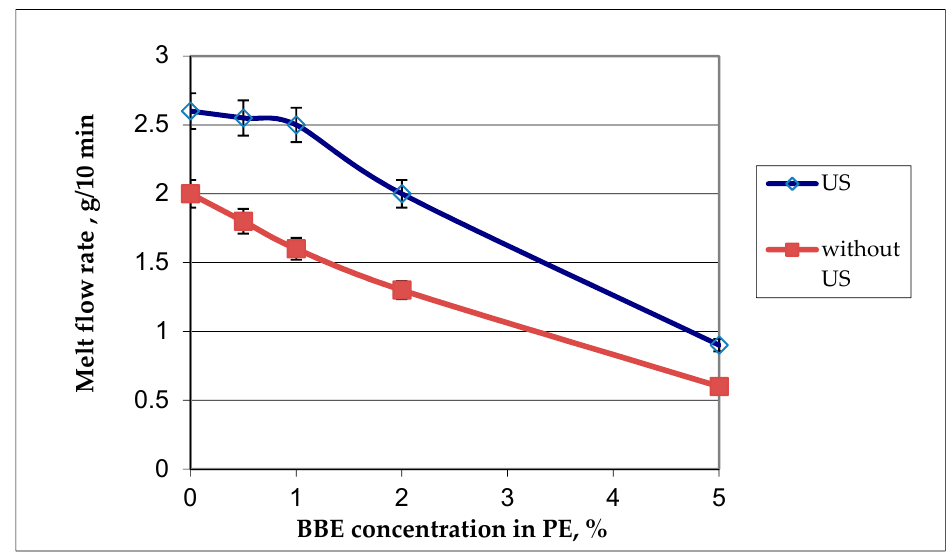
Figure 4. Graphic dependance of the melt flow rate on the birch bark extract (BBE) content in polyethylene (PE) and on ulrasonic (US) treatment.